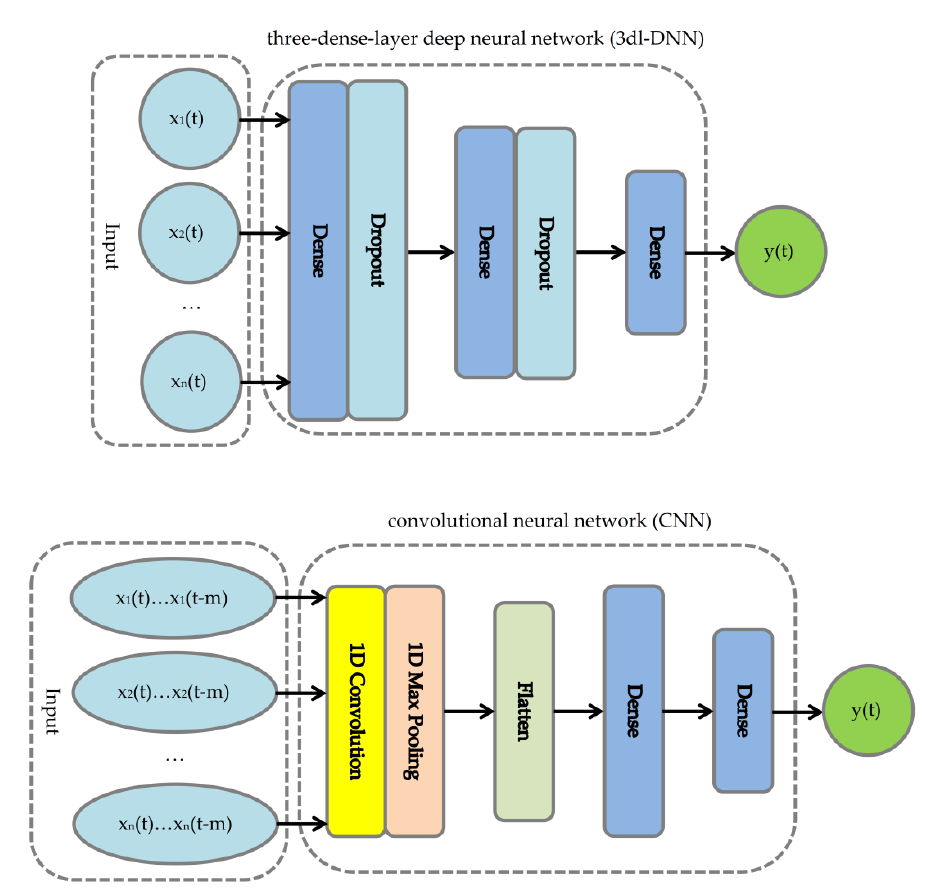
Figure 4. The structure of the deep neural networks (DNNs) used in the research.